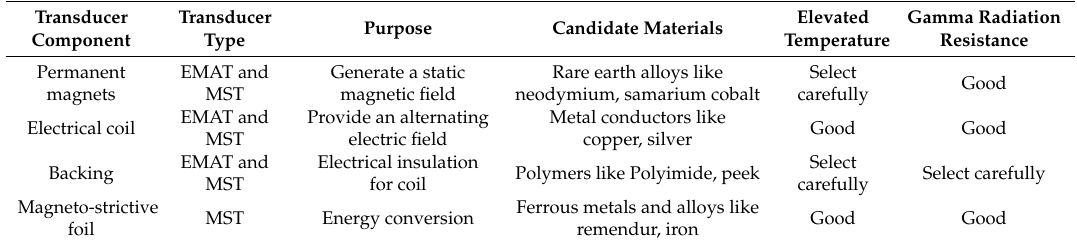
Table 1. Material selection considerations for transducer components.